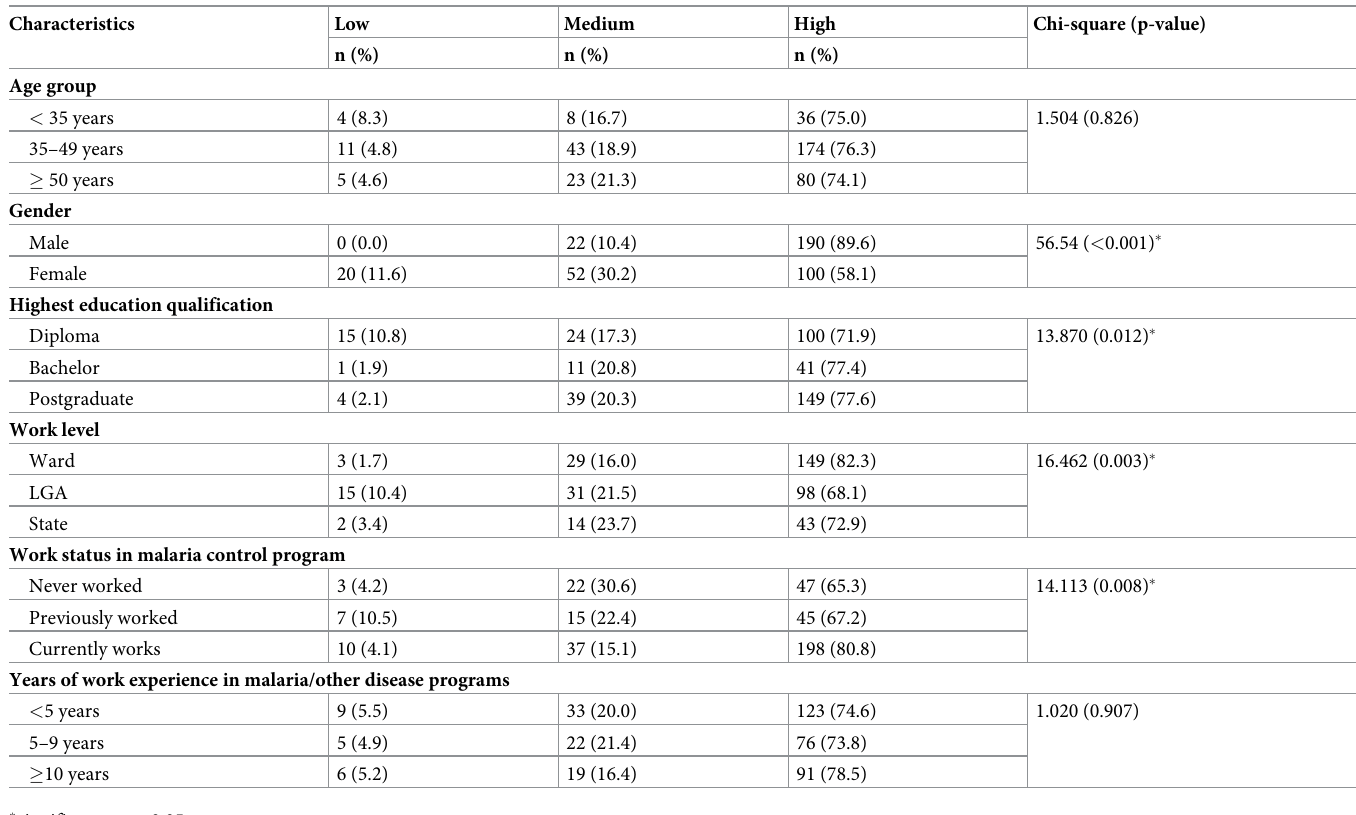
Table 4. Distribution of respondents’ level of priority ratings of topics in the selected thematic domains by demographic characteristics.